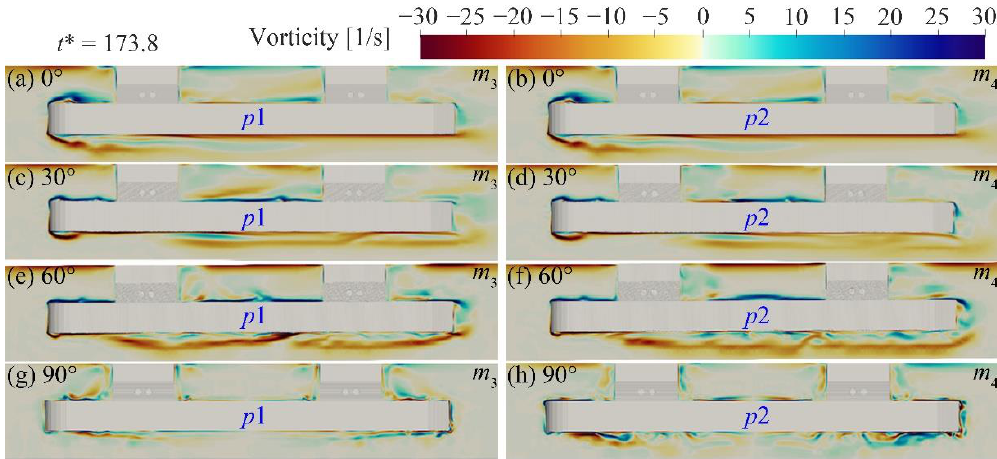
Figure 16. Comparison of the vorticity field around the semi-submersible platform at different angles at profile m 3 and m 4